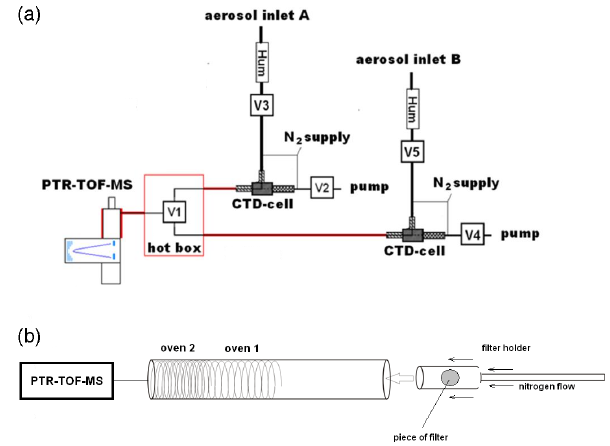
Figure 1. The in situ (a) and offline (b) TD-PTR-MS setups. The following valves are present on scheme A: V1, which allows switch- ing between two aerosol inlets; and V2–V5, which allow switching between sampling and measuring modes for inlet A and B. The fig- ure and the caption are taken from Timkovsky et al.